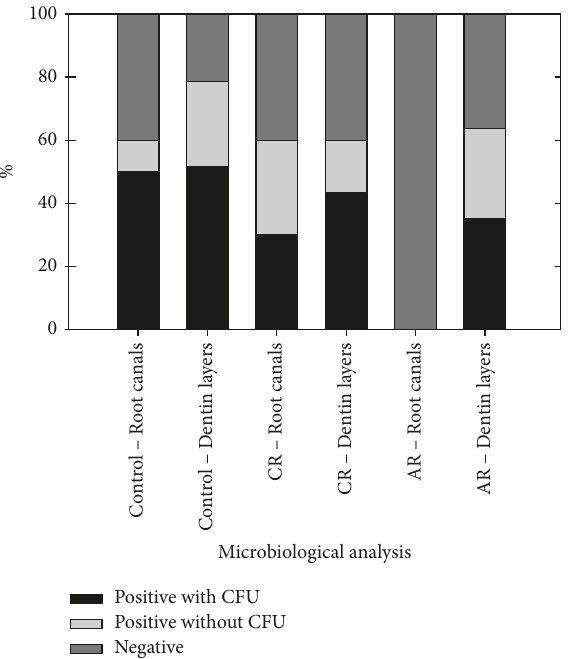
Figure 3: Relative frequency of the microbiological conditions in the root canals and respective dentin. Control group: irrigation with 0.85% saline; group 1: irrigation with NaOCl, final rinse with EDTA, and irrigation with NaOCl (CR); and group 2: irrigation with a NaOCl/EDTA/NaOCl combination